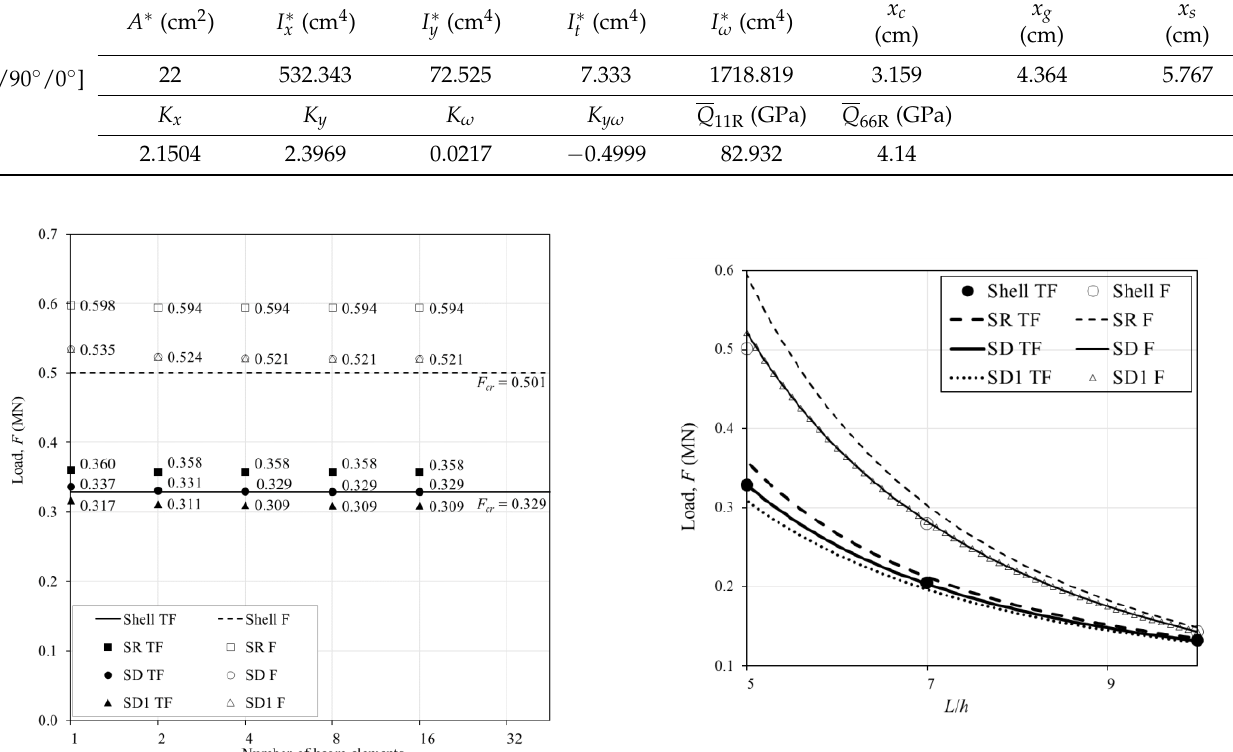
Figure 6. Cantilever beam: ( a ) geometry and ( b ) lateral-torsional buckling mode. Four different mesh configurations, each consisting of two, four, eight, and sixteen beam elements, are used to analyze the lateral-torsional buckling mode in Figure 6b. Since